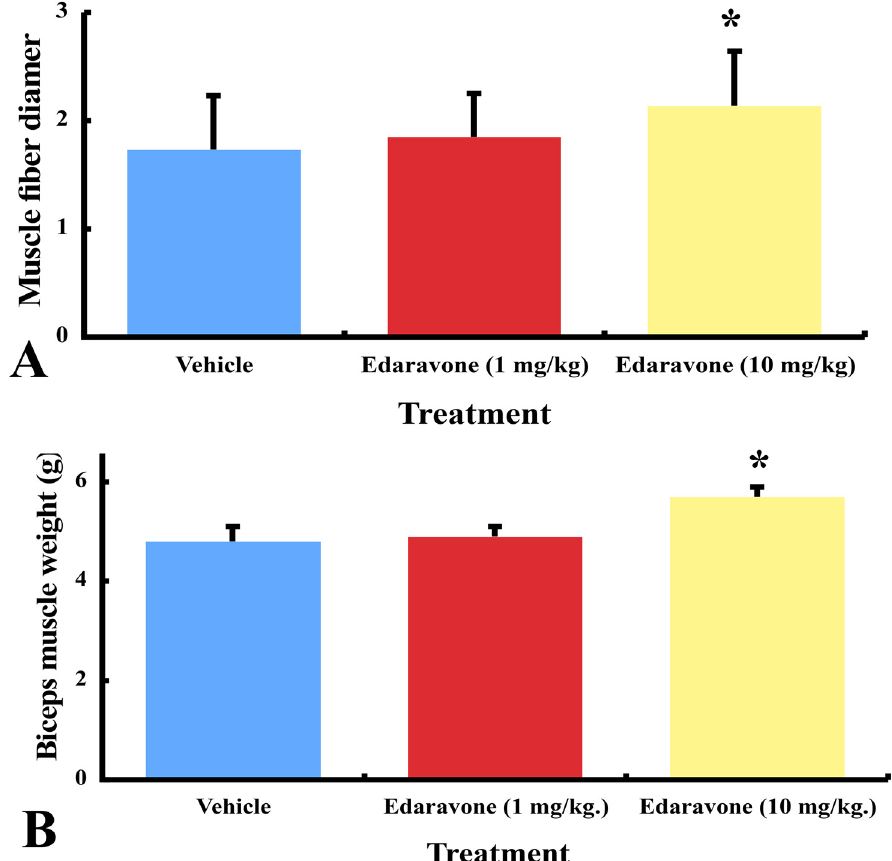
Fig 2. The biceps muscle weight and morphometry in edaravone- and vehicle-treated wobbler mice. (A) Mice treated with higher dose of edaravone increased significantly the weight of biceps muscles compared to vehicle. * P < 0.05, the higher dose of edaravone group versus the vehicle group (one-way ANOVA followed by Dunnett multiple comparison test). Results are represented as the mean ± SEM (n = 10/ group). (B) Mice treated with higher dose of edaravone increased the diameter of muscle fibers significantly compared to vehicle. * P < 0.05, the higher dose of edaravone group versus the vehicle group (one-way ANOVA and Dunnett multiple comparison test). Results are represented as the mean ± SEM (n = 10/group).